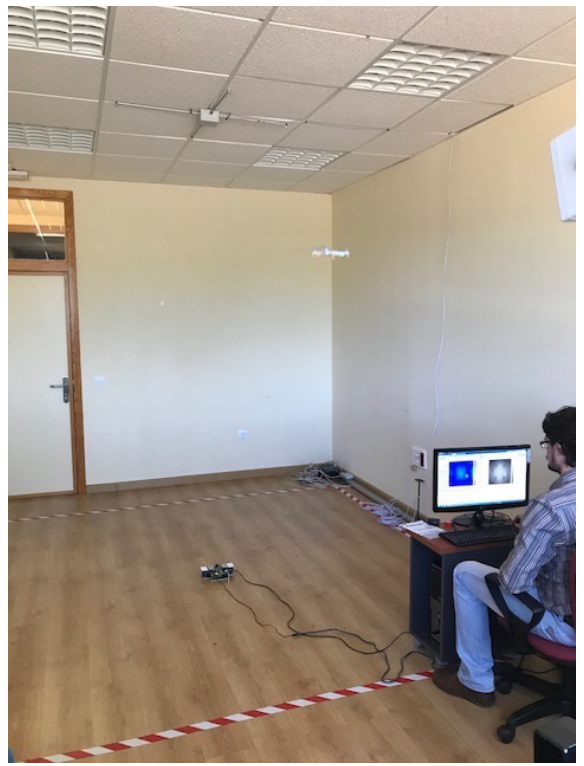
Figure 9. Snapshot of the experimental site, with the ULPS installed in the ceiling of an office room and the TOF-camera placed at the origin of